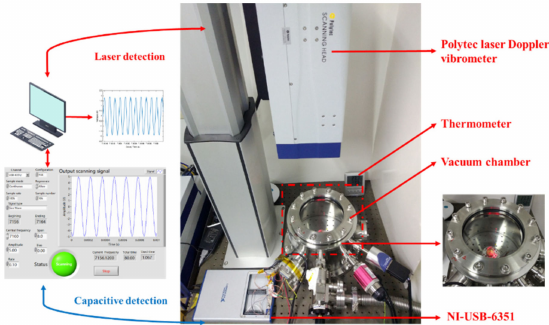
Figure 6. The testing present and apparatus of optical and electrical method characterizing the fused cylindrical